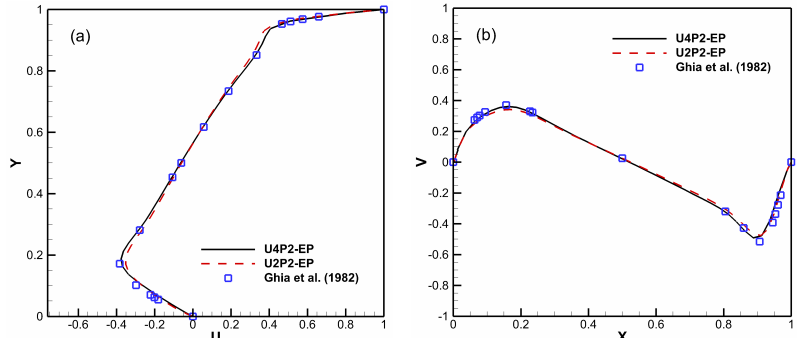
Figure 6. Comparison of ( a ) horizontal and ( b ) vertical velocity components at the vertical and horizontal centerlines with reference data of [61]. Upper: x -velocity. Lower: y